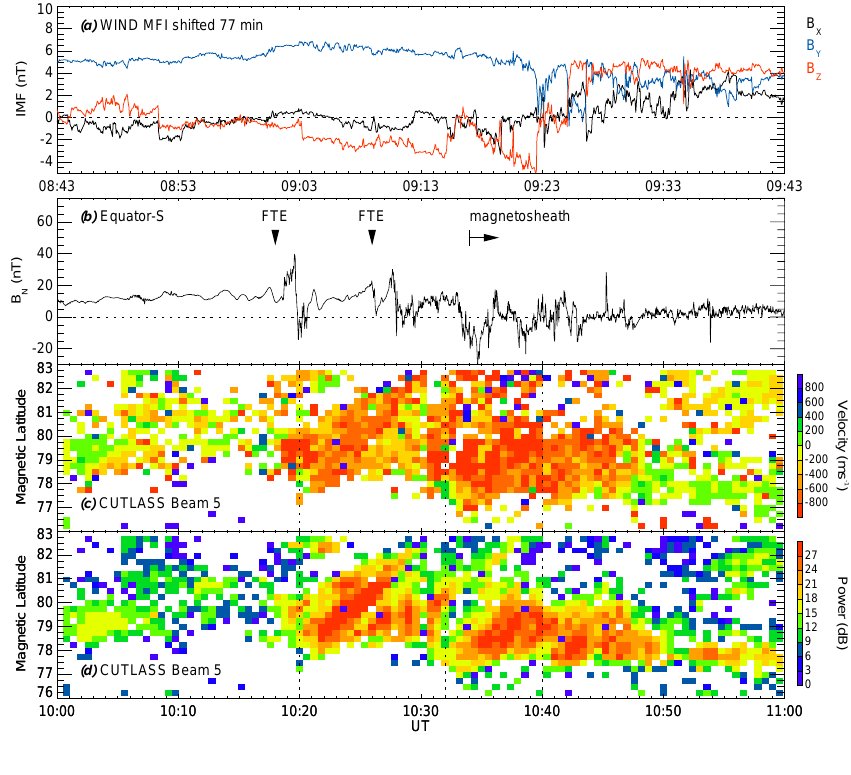
Fig. 1. (a) The Wind upstream IMF GSM B x , B y and B z component data during the interval under study. The data is timelagged by 77 min relative to the panels presented below (b) Equator- S boundary normal component mag- netic field from the magnetopause re- gion (c) Colour-coded (positive (blue) velocities are toward the radar, negative (red) velocities away from the radar) CUTLASS Hankasalmi beam 5 line-of- sight velocity data as a function of mag- netic latitude (d) Colour-coded CUT- LASS Hankasalmi beam 5 backscat- tered power data as a function of mag- netic latitude. Times of FTE-associated enhanced ionospheric flow onsets are marked with dashed vertical lines in panels c and